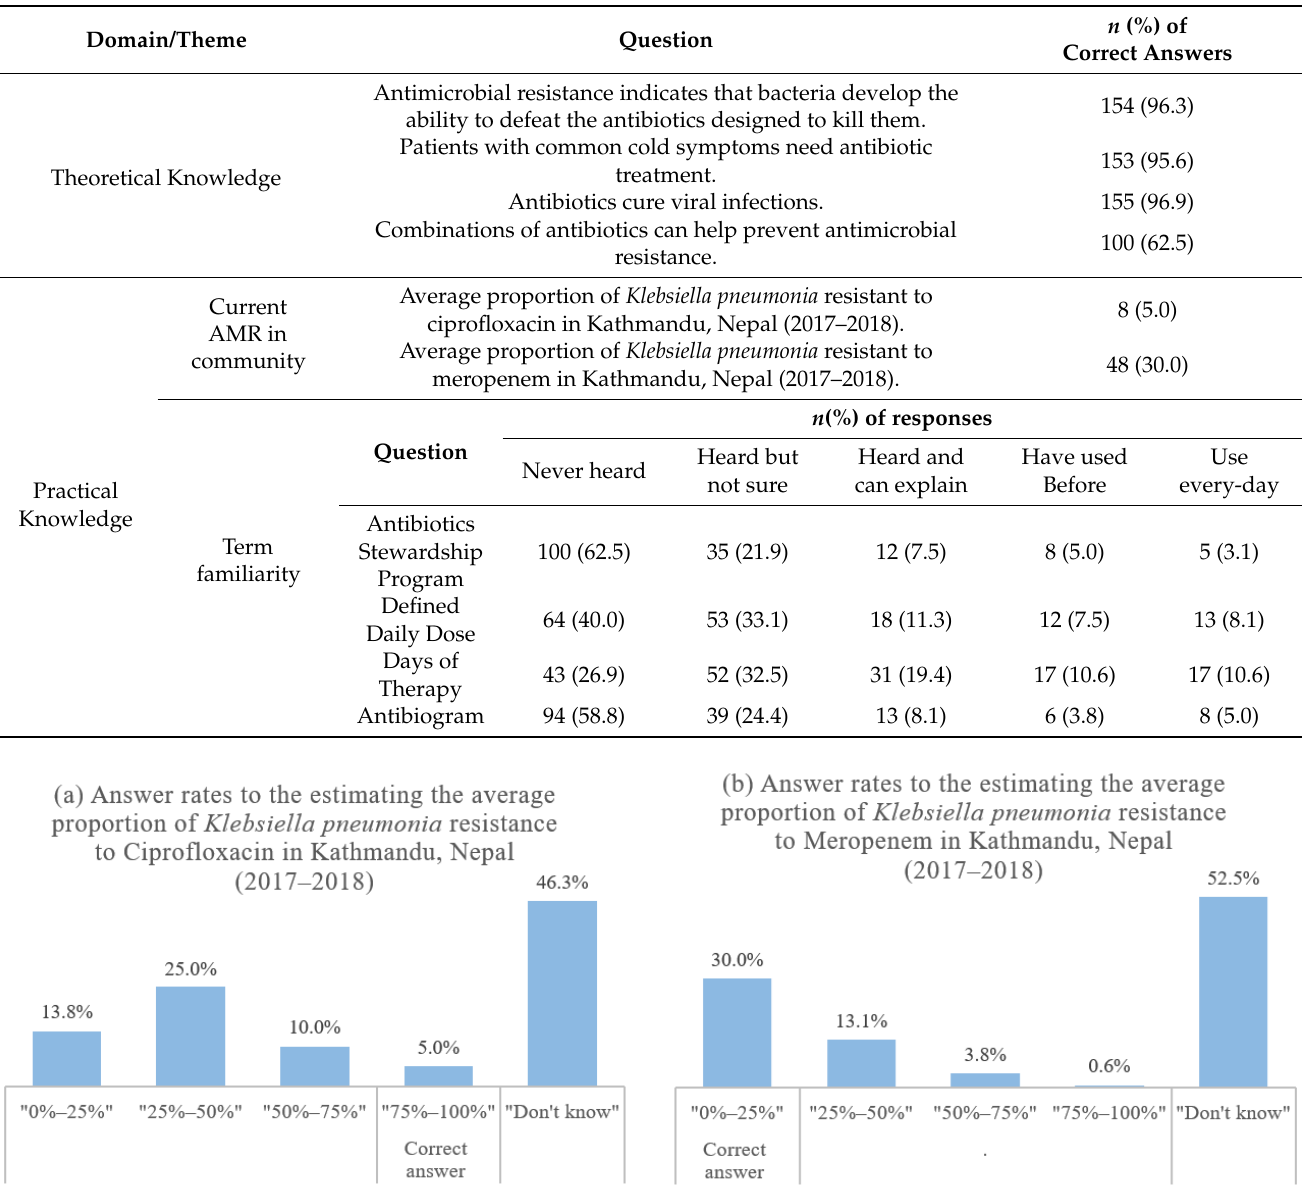
Table 3. Results of the knowledge test ( n = 160).